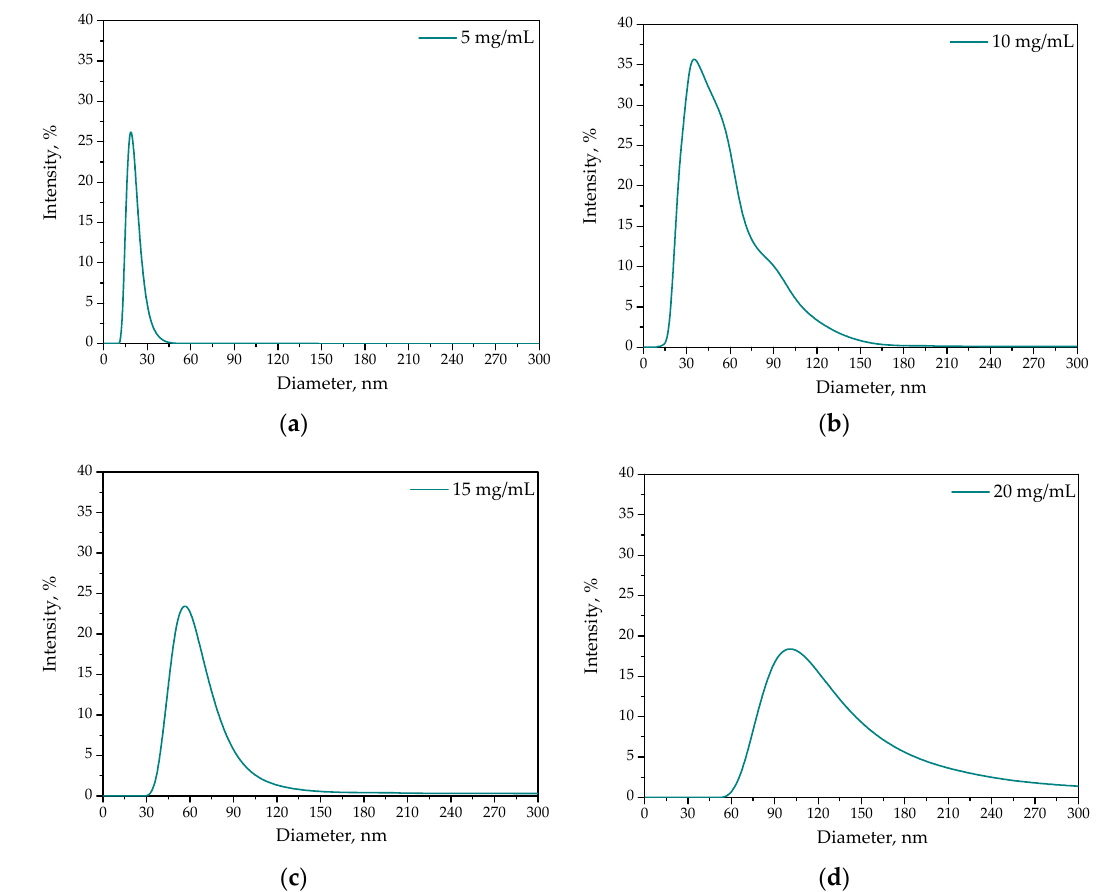
Figure 3. Results of DLS analysis of protein particles obtained using albumin solution at a concentration of 5 mg/mL ( a ), 10 mg/mL ( b ), 15 mg/mL ( c ) and 20 mg/mL ( d ).